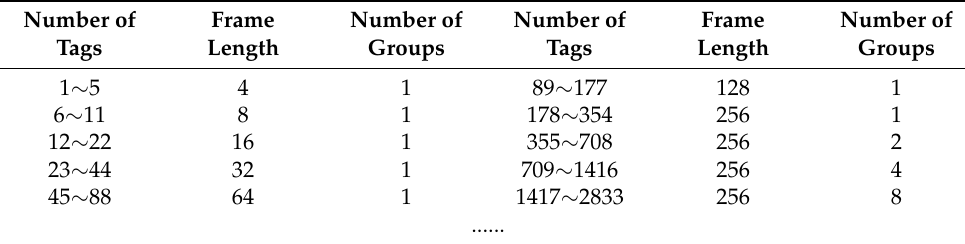
Table 4. Tag grouping results.